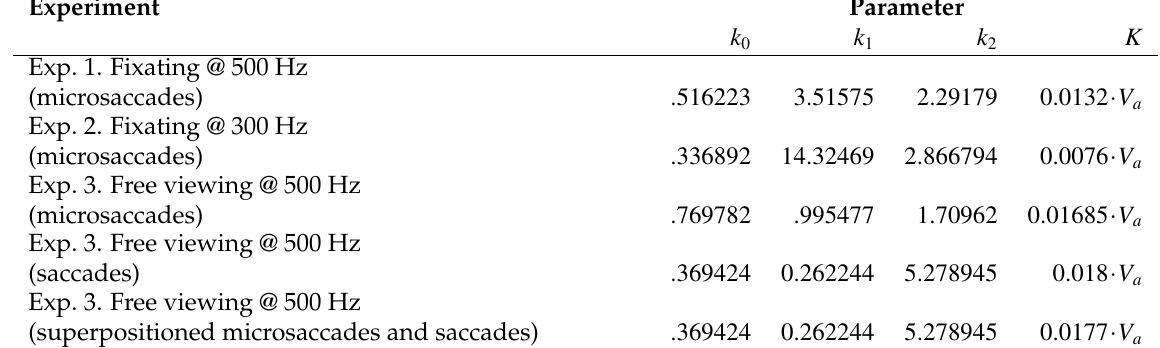
Linear coefficients for the inverse-linear logistic function fit to duration-amplitude of all data sets.